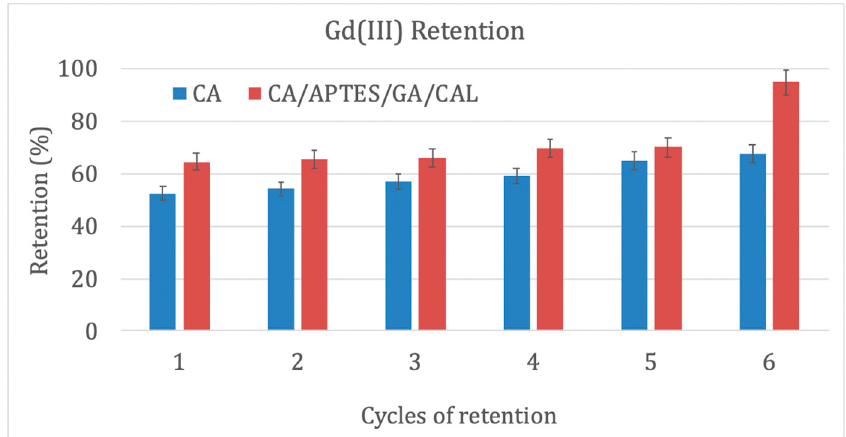
Figure 11. Gd(III) retention (%) related to feed solution through CA and CA/APTES/GA/CAL membranes. Five different measurements for calculating standard error.